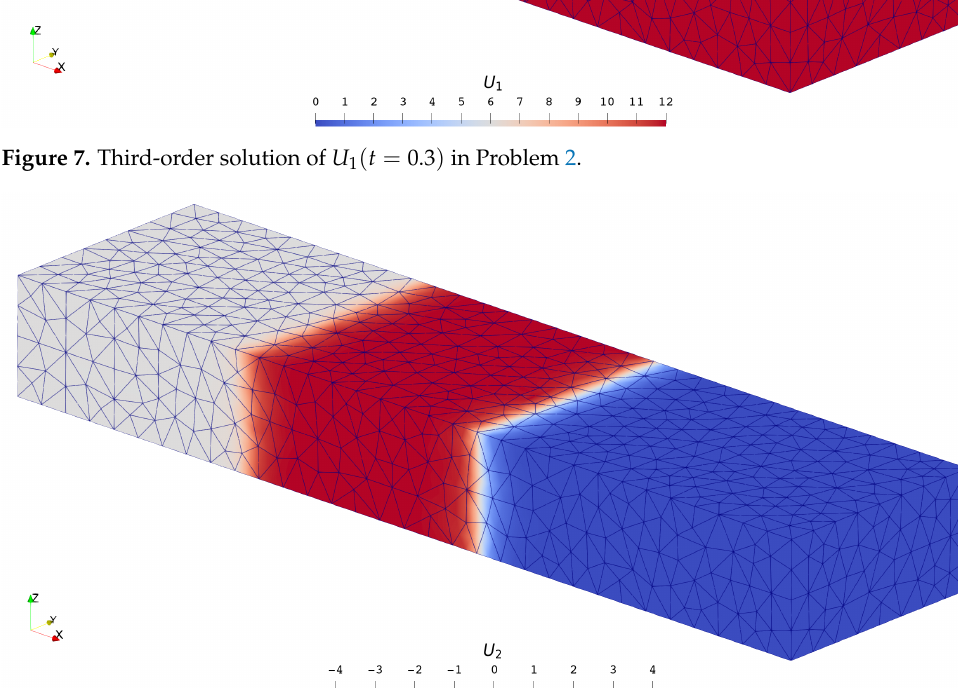
Figure 8. Third-order solution of U 2 ( t = 0.3 ) in Problem